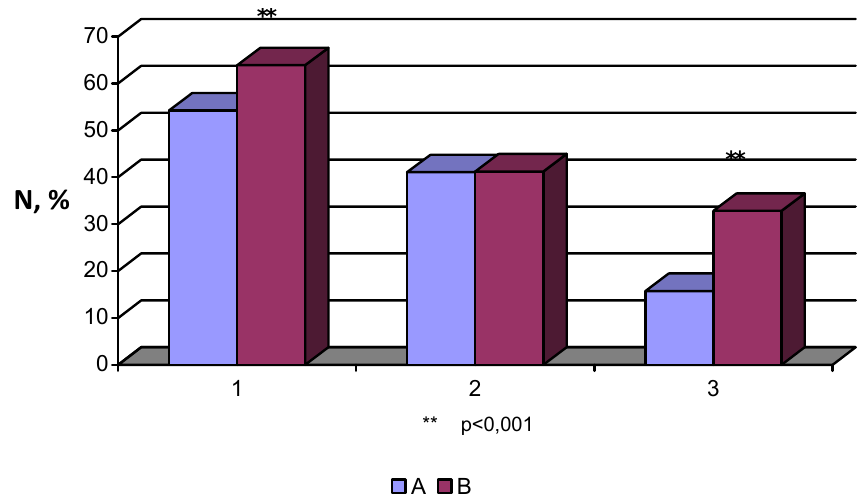
Fig.2. Comparative performance of realization of team throws of qualified healthy sportswomen (A) and sportswomen with hearing abnormalities